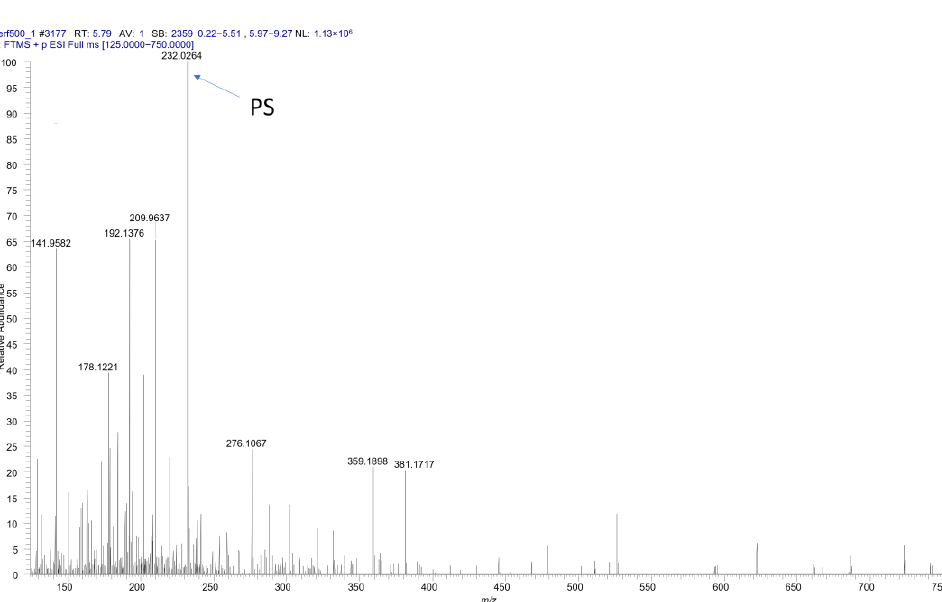
Figure A3. HRMS spectrum of paracetamol β -D-glucuronide generated in rat small intestine luminal after 90 min of perfusion.